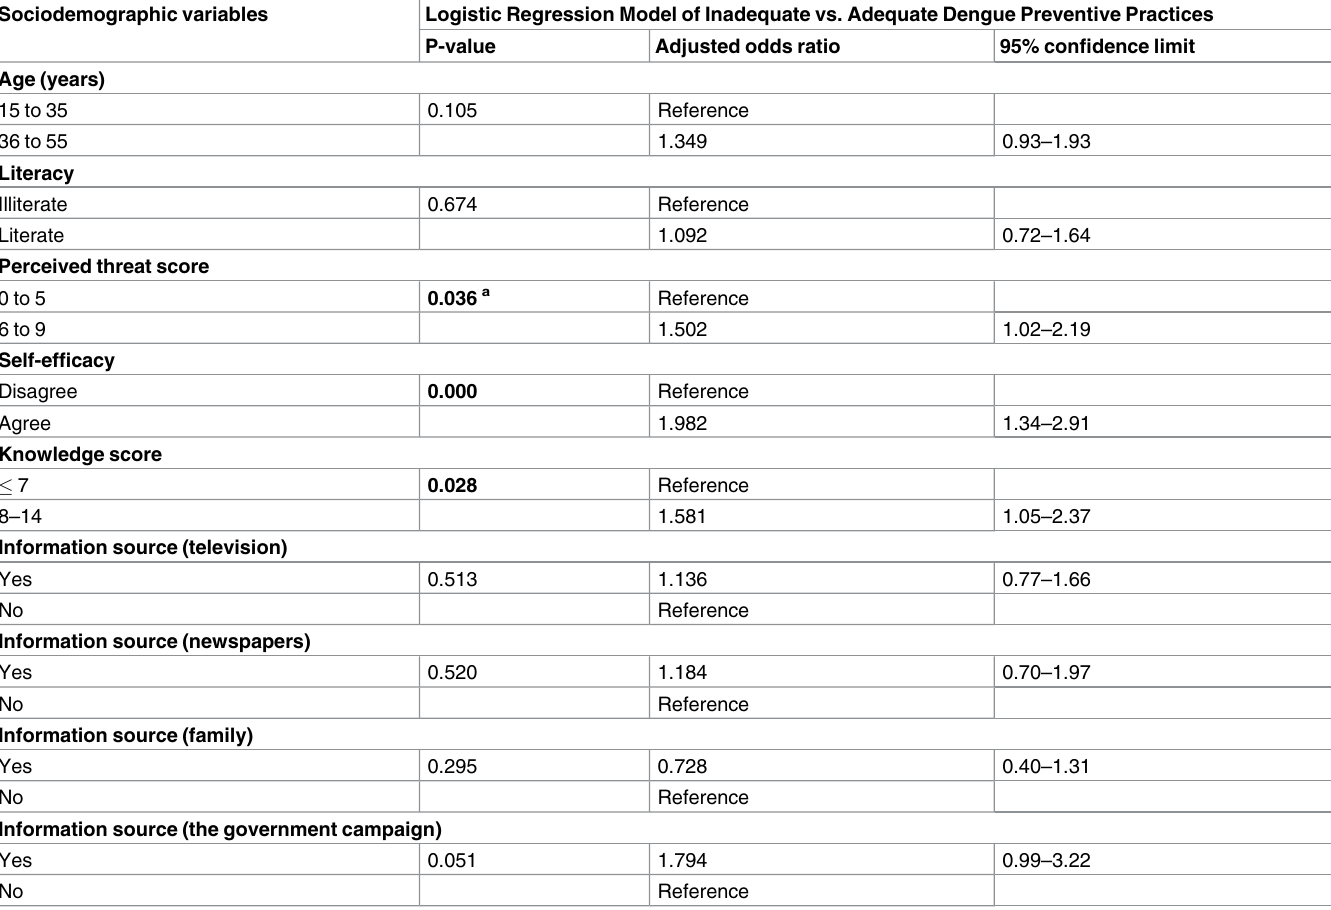
Table 5. Multivariate Logistic Regression Analysis of Variables Associated with Dengue